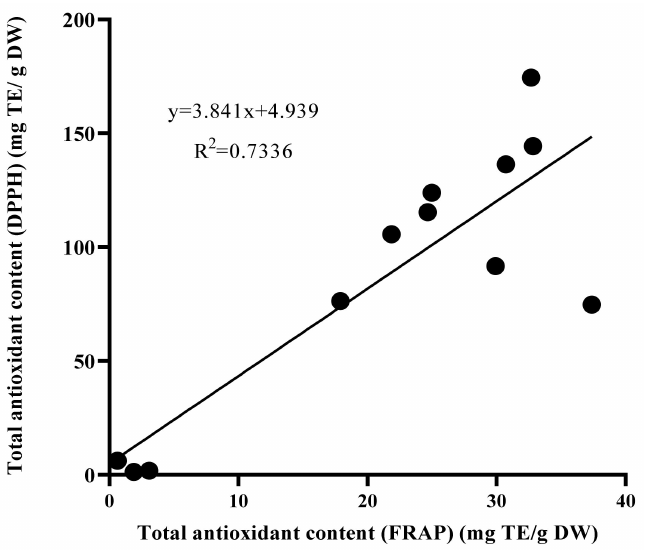
Figure 5. Correlation (R 2 ) between antioxidant activities using FRAP and DPPH methods in leaf extract of wild plant, in vitro plantlet, and callus of Labisia pumila var. alata . DPPH = 2,2-diphenyl-1- picrylhydrazyl, FRAP = ferric reducing antioxidant potential.